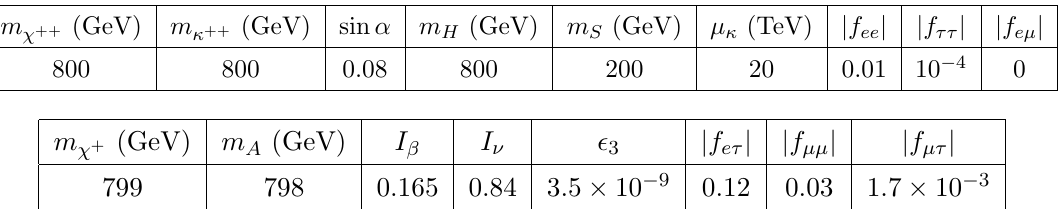
Figure 3 . Regions corresponding to the observed relic abundance [48] in the m S - (cid:21) S plane for di(cid:11)erent values of sin (cid:11) . We have chosen m H = m plot. Current [49, 50] and future [51] bounds from direct detection experiments are also marked appropriately.